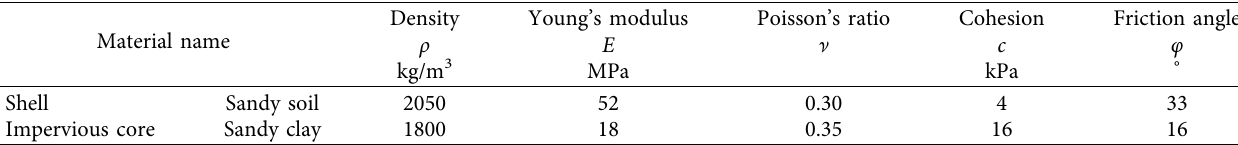
Figure 4: The schematic cross sections in the case of the same steady safety factors on the upstream slopes: (a) homogeneous dam, (b) CCD, and (c) SUCD. Table 1: Physicomechanical parameters of